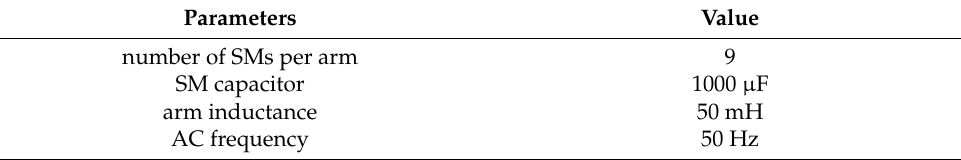
Table 2. Parameters of MMC [33].